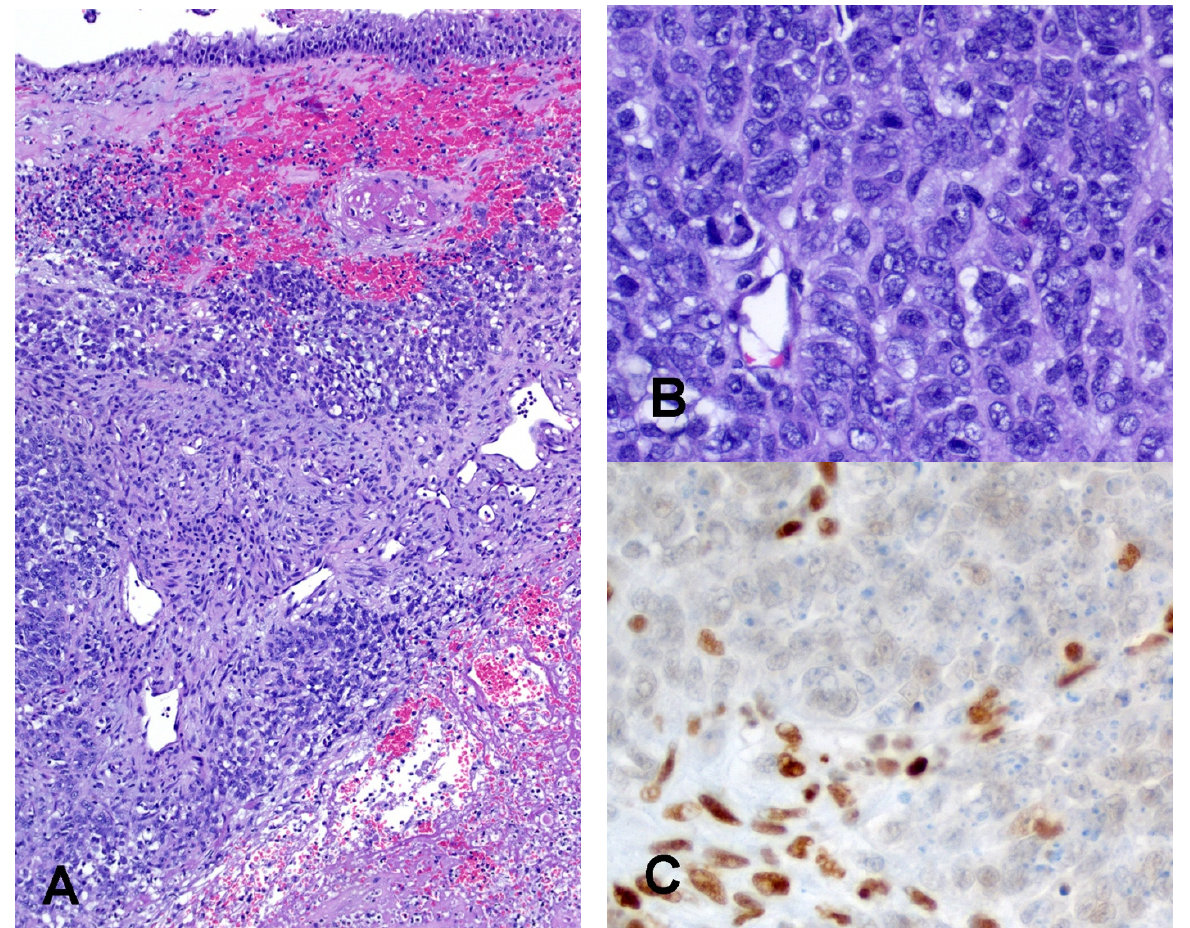
Figure 4. SMARCA4 deficient sinonasal carcinoma. Nests of undifferentiated tumor cells are present in the nasal mucosa ( A ) (Hematoxylin and eosin, 10× Objective original magnification). Tumor cells are large and show vesicular nuclei with multiple nucleoli and moderate amounts of cytoplasm ( B ) ( Hematoxylin and eosin, 40× Objective original magnification ) . Immunohistochemistry shows complete loss of SMARCA4 in neoplastic cells, while nuclear positivity is retained in stromal cells ( C ).